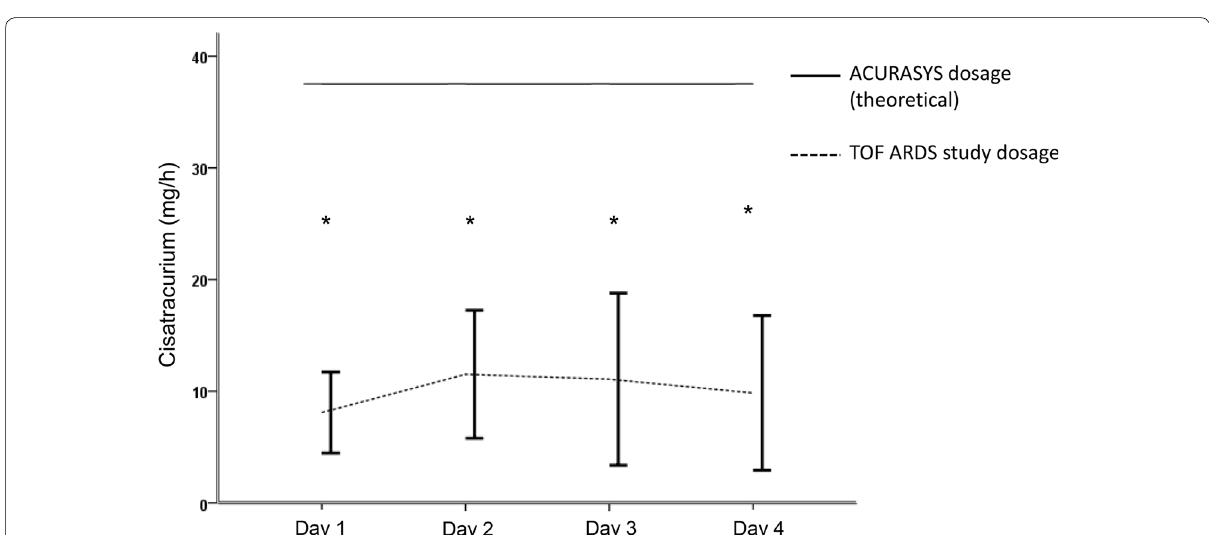
Fig. 2 Mean daily cisatracurium dosage. The data are presented as the mean that would have been used following the ACURASYS study protocol (37.5 mg/h). * p < 0.001 between ACURASYS and TOF‑ARDS dosage